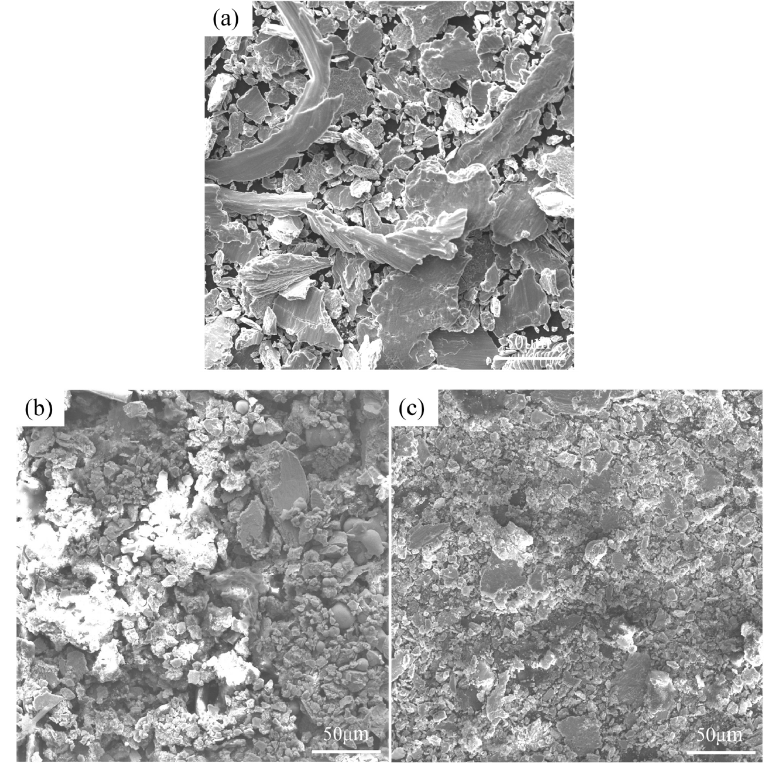
Figure 10. SEM images of the wear debris of ( a ) Ti6Al4V, and the coatings ( b ) without CeO 2 and ( c ) modified with CeO 2 .